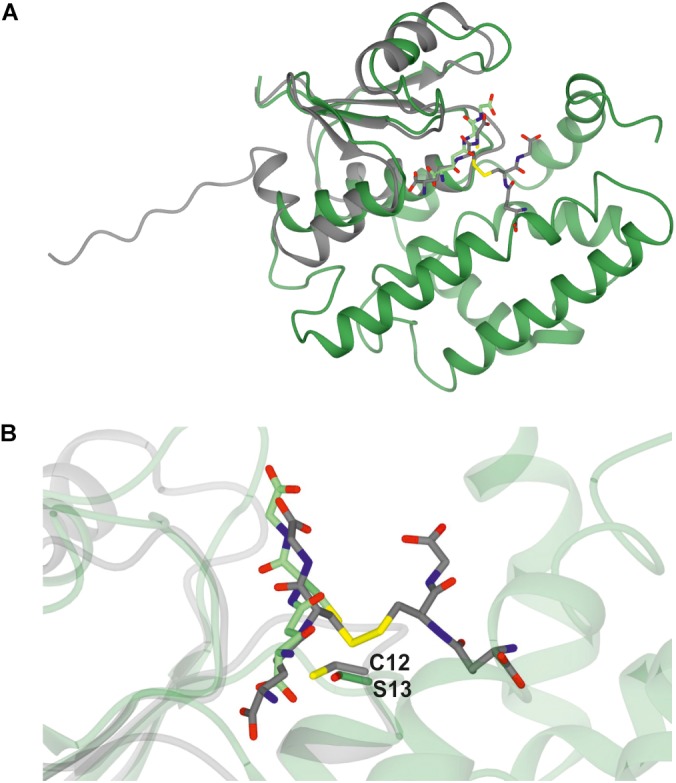
Comparison of GSTU25 with CoGRX2. (A) Superimposed structures of the glutaredoxin subunit from Clostridium oremlandii (CoGRX2 in complex with GSSG (C-atoms in gray), and the GSTU25 subunit (green) in complex with GSSG (C-atoms in green). The RMS value for the superimposed structures is 2.3 Å over 73 residues. (B) Position of the active residue for GSH thiol stabilization: serine 13, in GSTU25 and cysteine 12 in CoGRX2.